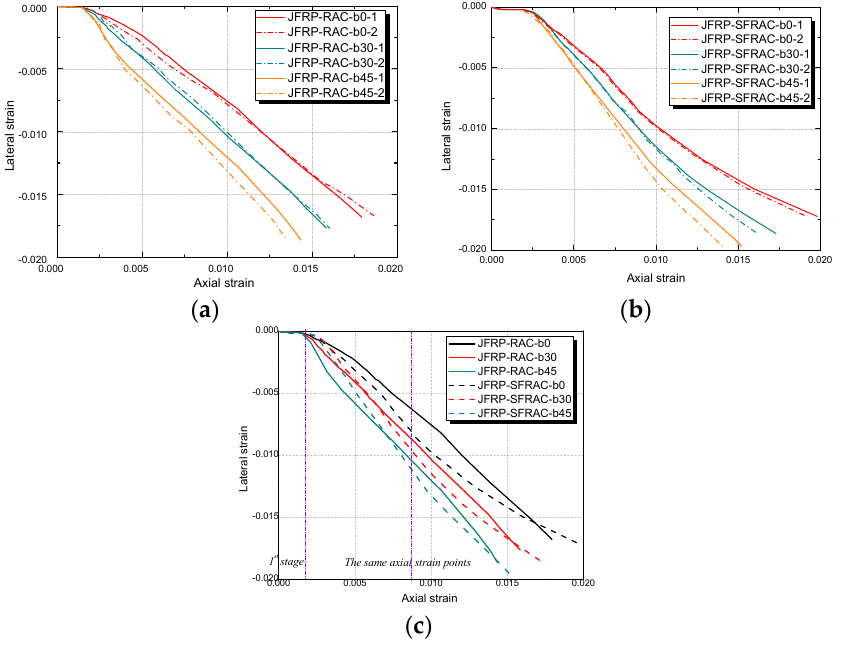
Figure 9. Lateral strain–axial strain of JFRP–RAC and JFRP–SFRAC: ( a ) JFRP–RAC; ( b ) JFRP–SFRAC; ( c ) Comparison between JFRP–RAC and JFRP–SFRAC. Table 7. The compressive properties of the